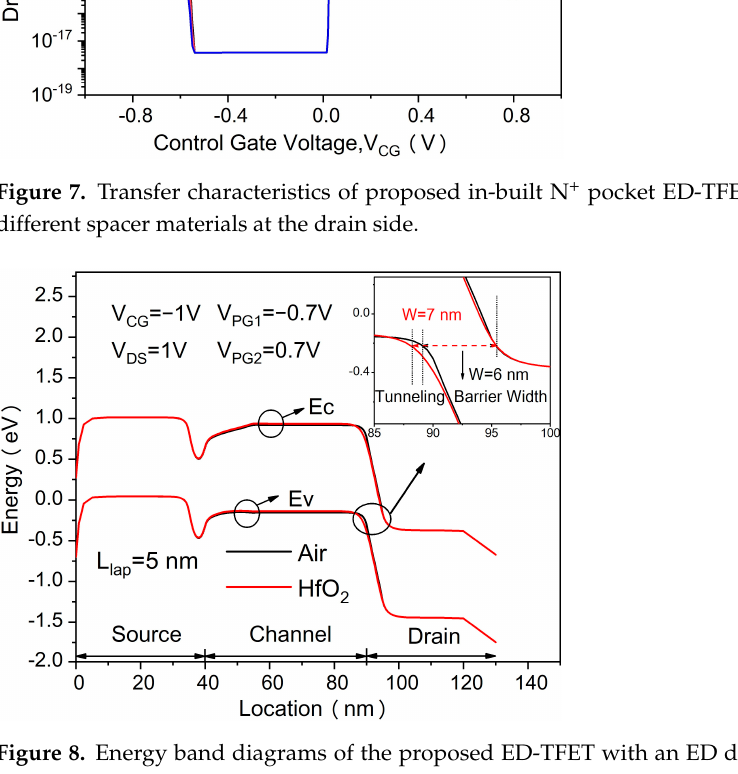
Figure 8. Energy band diagrams of the proposed ED-TFET with an ED drain with Air and HfO 2 spacer at the drain side.